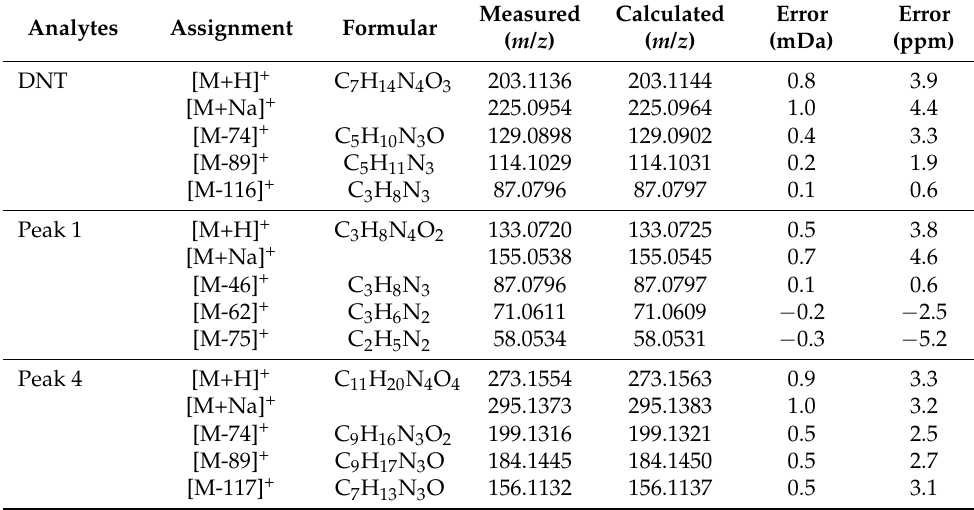
Table 1. Exact masses of DNT and